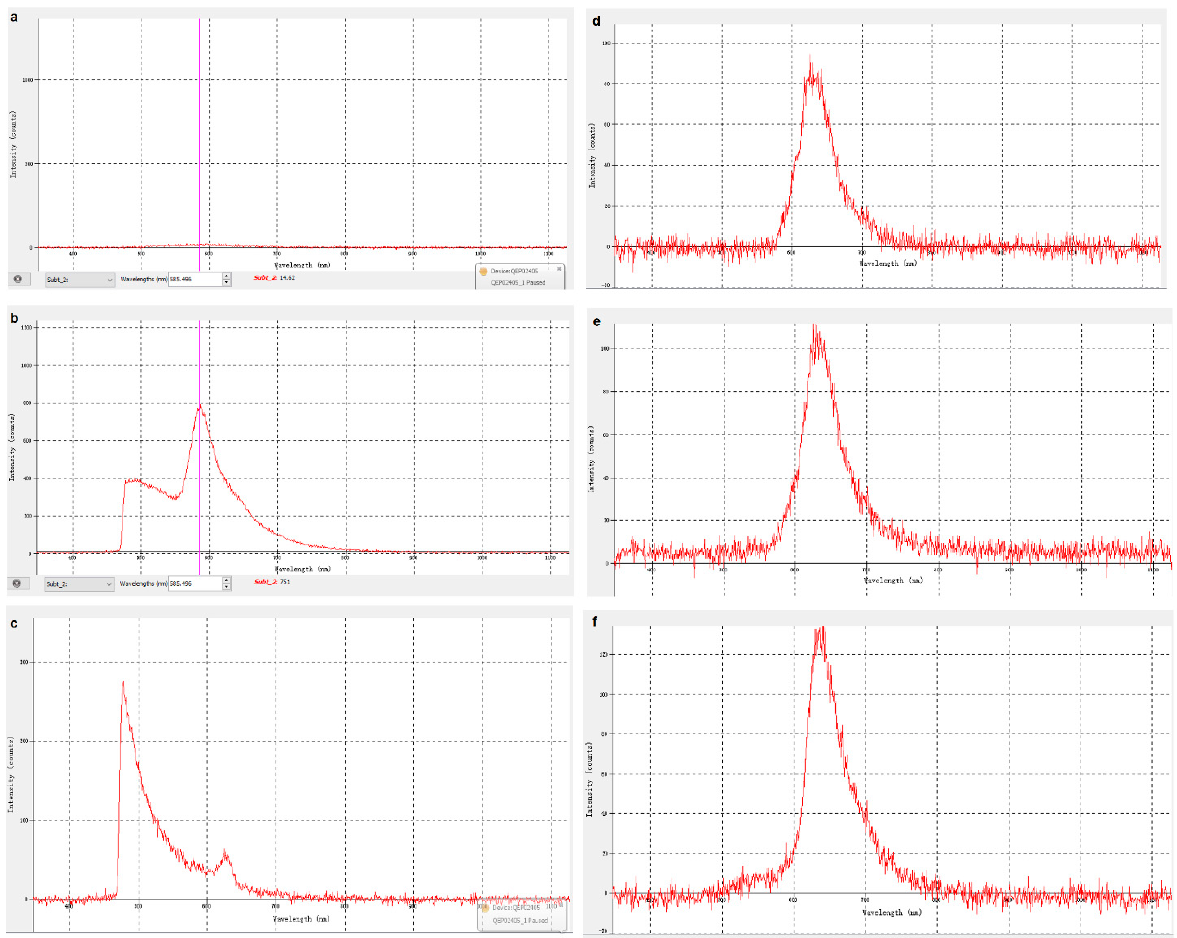
Figure 11. Spectrum without signal ( a ), fluorescent signal waveform 385 nm UV-LED without filter ( b ), 255 nm UV-LED-filtered ( c ), 275 nm ( d ), 310 nm ( e ), 325 nm ( f